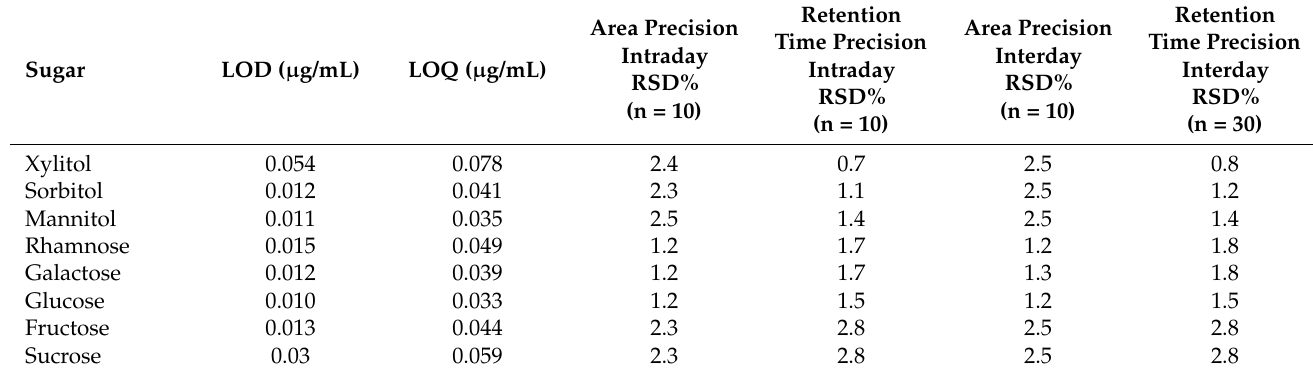
Table A3. LOD, LOQ, and precision of standards injected in PA1 column.